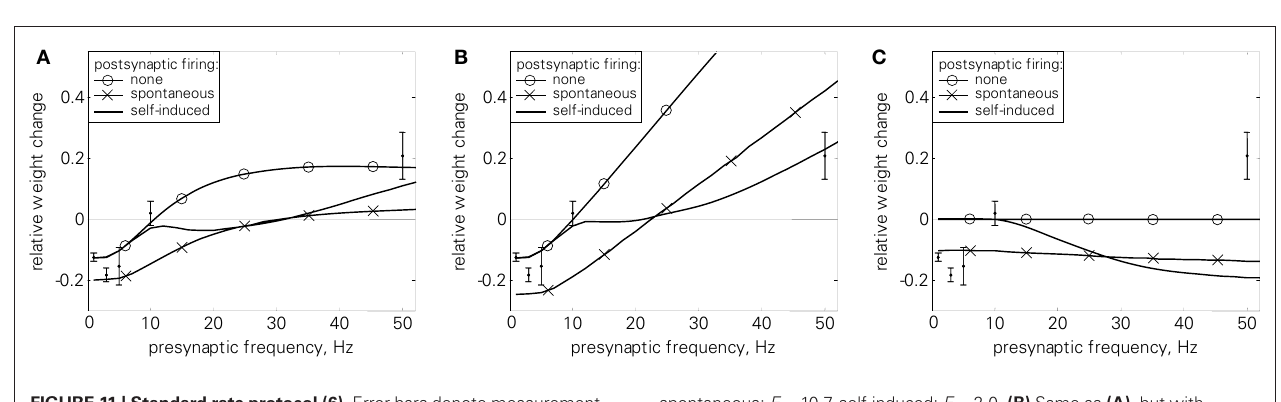
FigurE 11 | Standard rate protocol (6). Error bars denote measurement data by Dudek and Bear (1992). (A) LCP with LIAF for different postsynaptic spike settings, nearest-neighbor mode; Dudek parameter set (cf. text and Table 4 ); errors for the postsynaptic settings: none: E = 1.5,